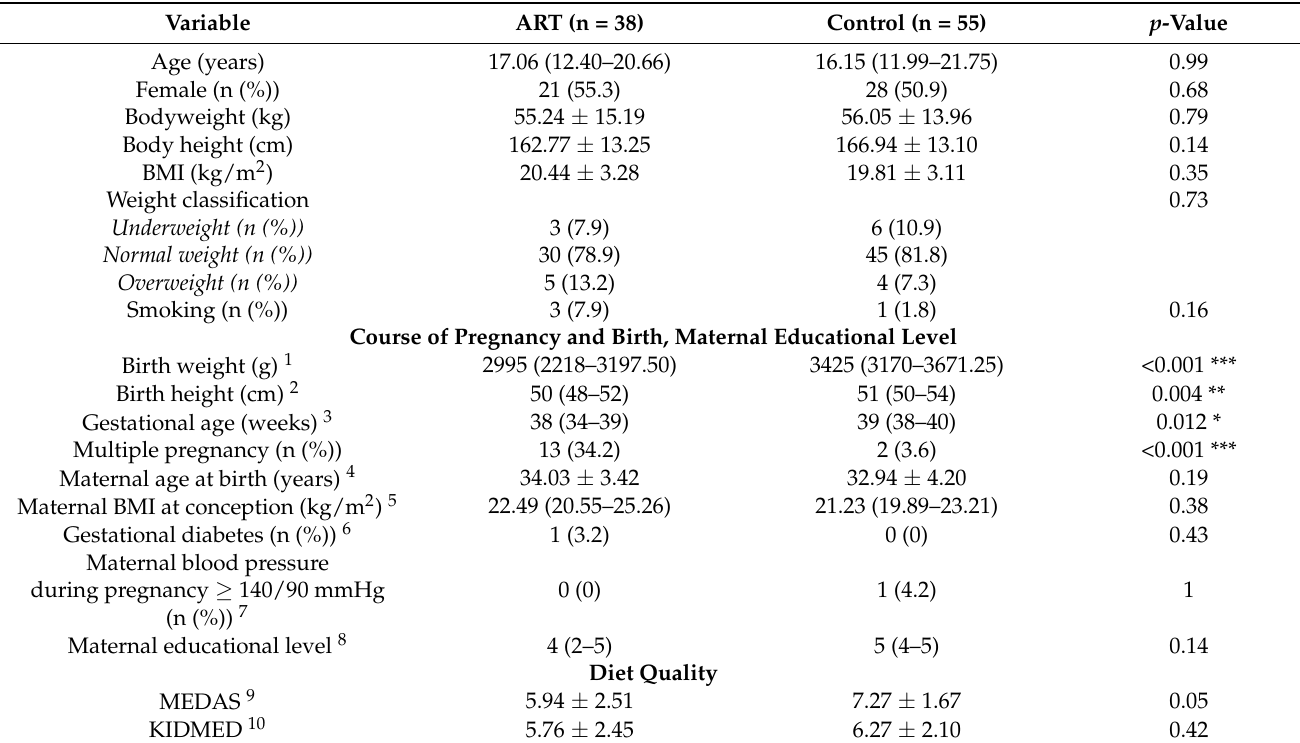
Table 3. Patients’ Characteristics in the ART and Control Group Aged ≥ 10